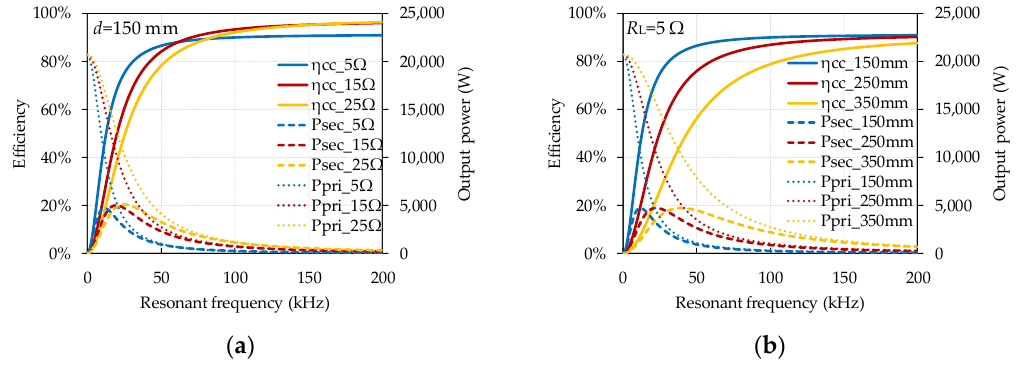
Figure 2. Effect of resonant frequency on the WPT system performance: ( a ) fixed coil-to-coil distance and varied load resistance; ( b ) fixed load resistance and varied coil-to-coil distance.